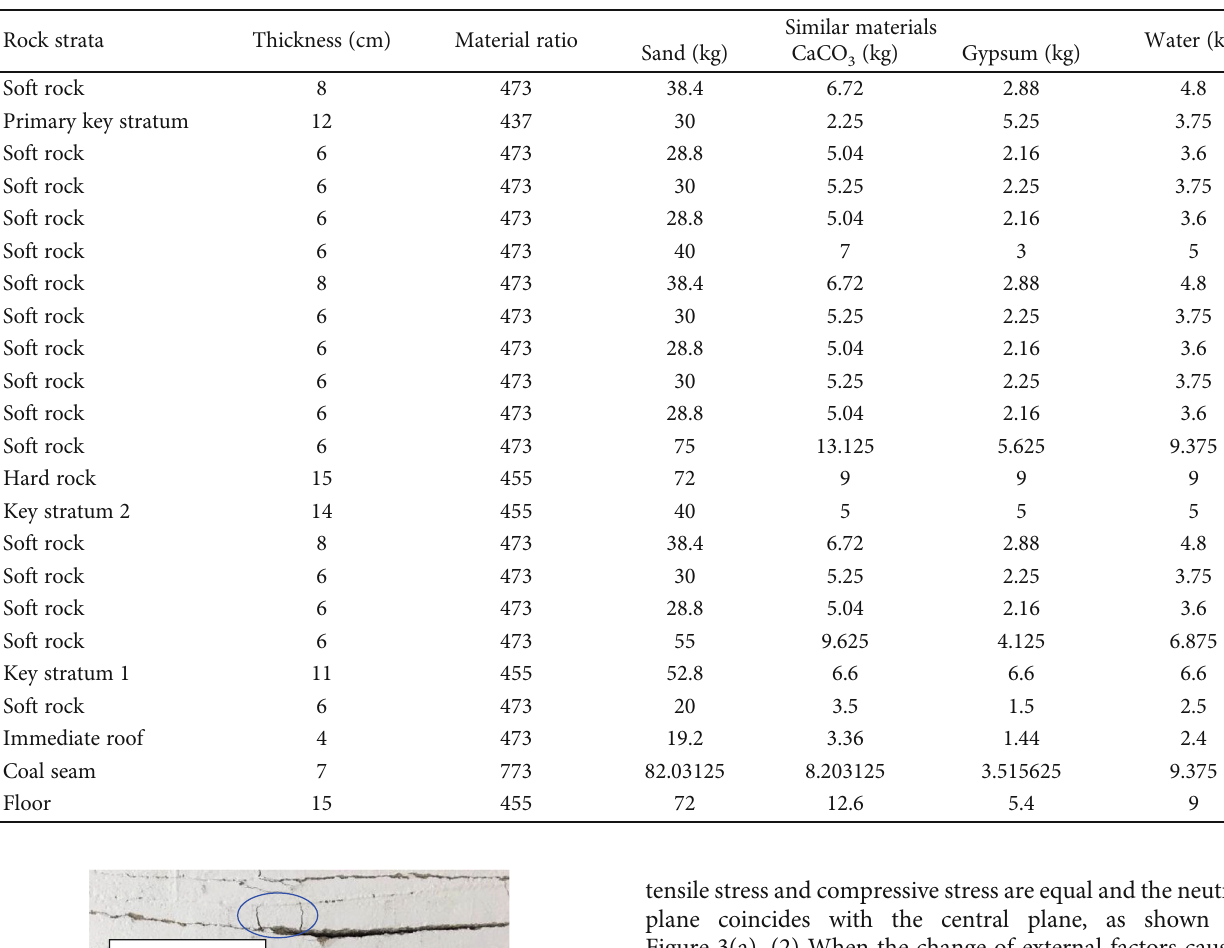
Table 1: Proportion of the similar simulation materials.